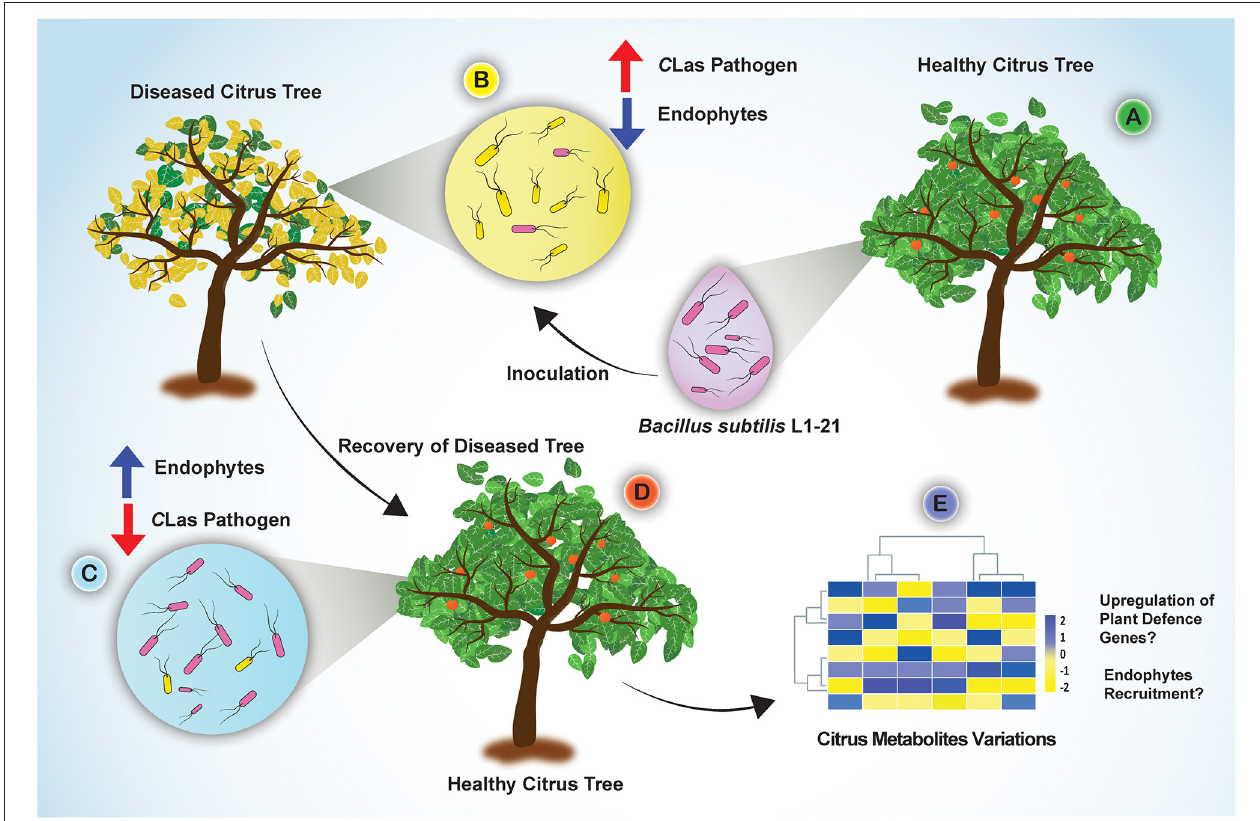
FIGURE 8 | Concluding sketch illustrating the different events taking place in the diseased citrus fields through restructuring bacterial endophytes for management of HLB disease. (A) Indigenous endophyte B. subtilis L1-21, displaying marked pinkish colonies, was isolated from healthy citrus plants; (B) Diseased citrus trees with more pathogen and less endophytes were inoculated with the endophyte B. subtilis L1-21; (C) Endophyte L1-21 shifted the bacterial endophytic community and excluded/restricted the pathogen colonization in diseased citrus trees from two different regions by regular application for 1 year; (D) The recovered tree showing more robust leaves and fruits; (E) Significant citrus metabolites were upregulated in the diseased citrus host after application of potential endophyte B. subtilis L1-21 ( Munir et al.,